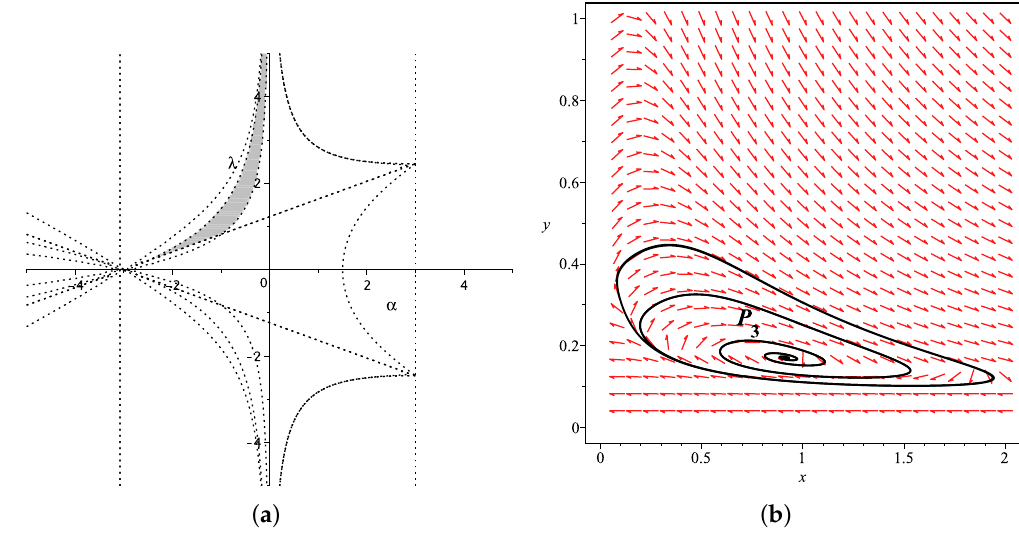
Figure 2. ( a ) The value range for parameters λ and α to make the critical point P 3 exist and stable, also constrained by other cosmological quantities, when x > 0. ( b ) The phase plane for λ = 11 and α = − 0.02 around the attractor P 3 = ( 0.915,0.171 ) when x >